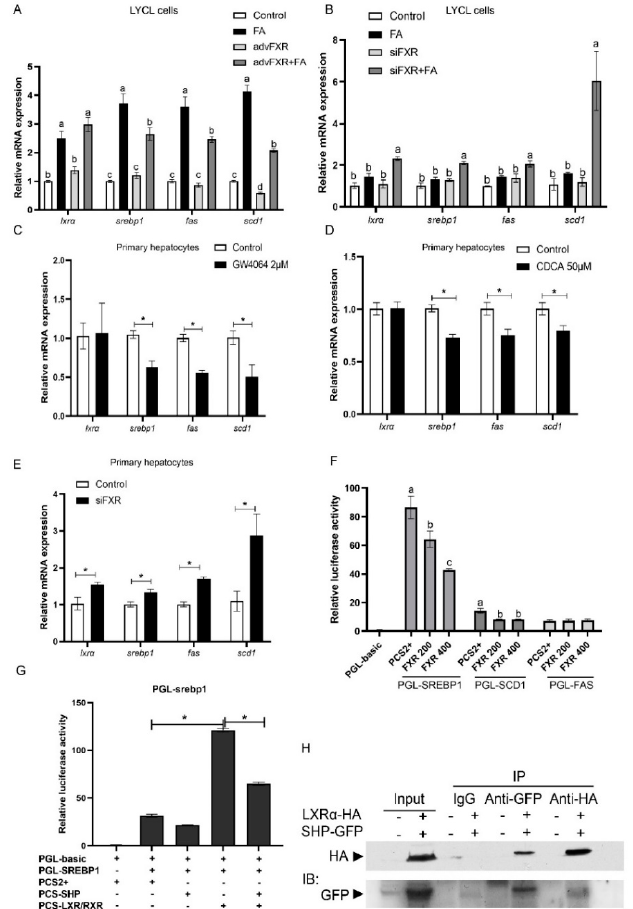
Figure 5. Effects of FXR on genes involved in lipogenesis of large yellow croakers: ( A , B ) Gene expression of lxr α , srebp1 , fas , and scd1 in LYCL cells after FXR overexpression or knockdown and treatment with FA; ( C – E ) gene expression of lxr α , srebp1 , fas , and scd1 in primary hepatocytes after GW4064 or CDFA treatment or FXR knockdown; ( F ) promoter activity of croaker SREBP1, SCD1, and FAS in HEK 293T cells after FXR overexpression; ( G ) promoter activity of croaker SREBP1 after LXR α and SHP overexpression; ( H ) analysis of protein interactions between LXR α and SHP of large yellow croaker. Data are shown as means ± SEMs ( n = 3) and were analyzed using Duncan’s multiple range test and Student’s t -test. The letters a–d indicate that there is a significant difference between means, * p <